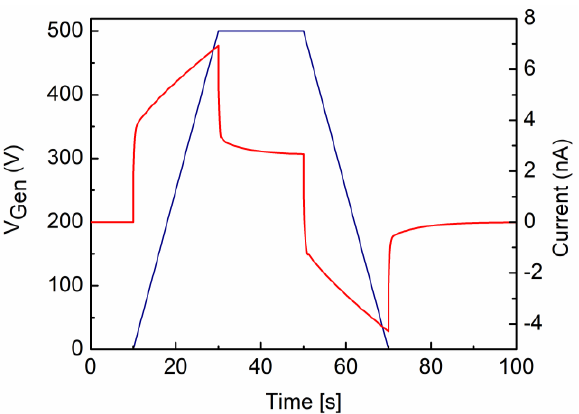
Figure 7. Simulated output (LTspice TM ) for a VRM cycle applied to the circuit of Figure 6a with parameters obtained from the best fit to experimental data with the equivalent circuit model. The